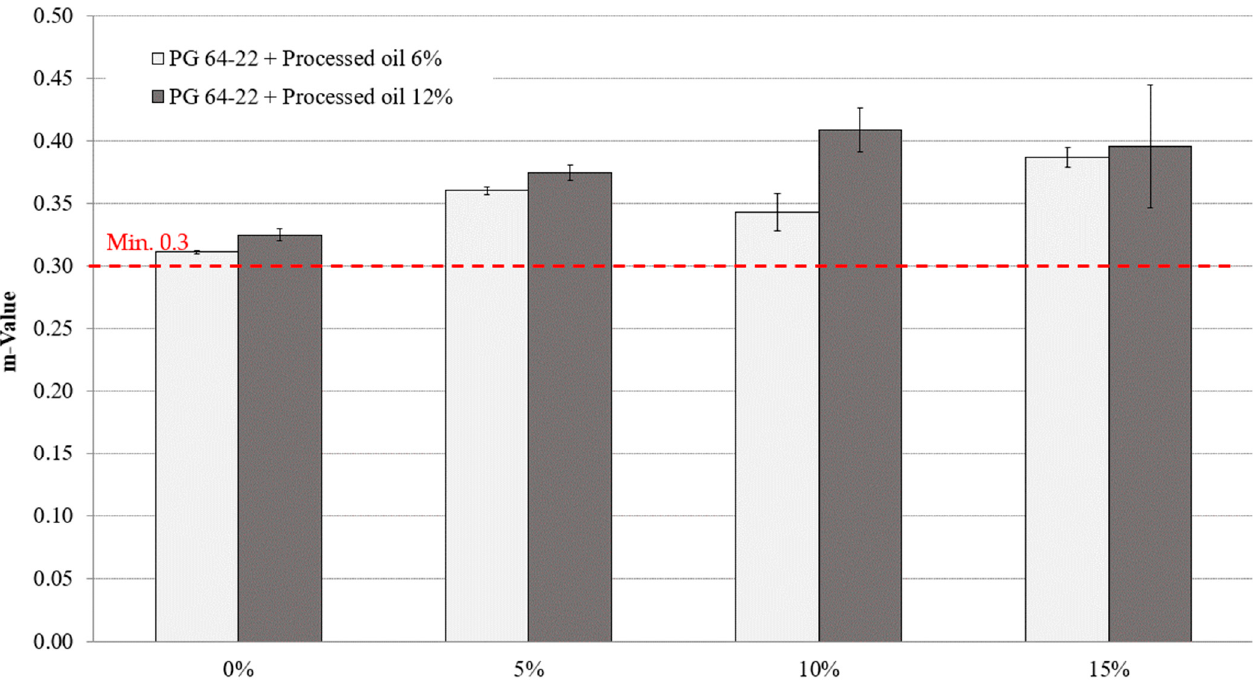
Figure 9. Effect of CRM content on m-value of processed oil-modified and long-term aged PG 64-22 binder aged at − 12 °C.